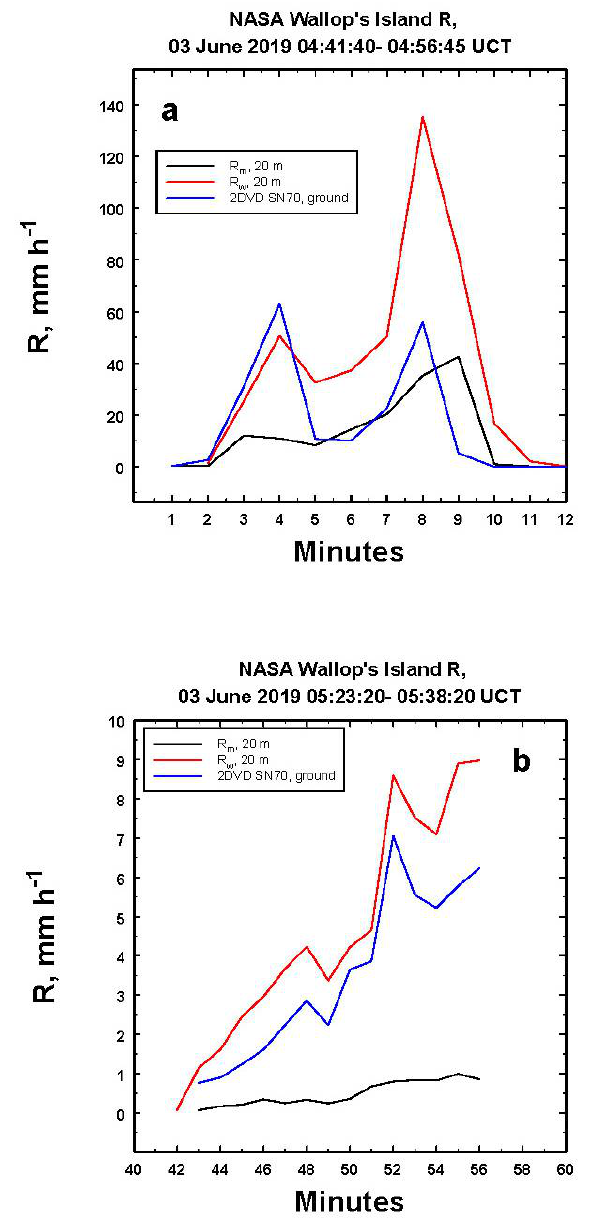
Figure 19. Comparisons of the MRR measured (black lines) average one-minute rainfall rates ( R m ) at 20 m AGL and of the air velocity adjusted (red lines) rainfall rates ( R w ) with the nearby 2DVD estimated rainfall (blue lines), as discussed in greater detail in the text for ( a ) the more convective time period and ( b ) for the later time period. Note the poor performance of the measured MRR values in ( b ).